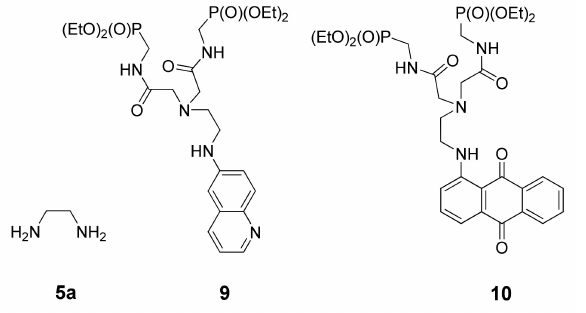
Figure 3. Structure of relevant compounds (i.e., 5a , 9 , and 10 ) for which protonation constants have been reported in the literature. The corresponding values are summarized in Table